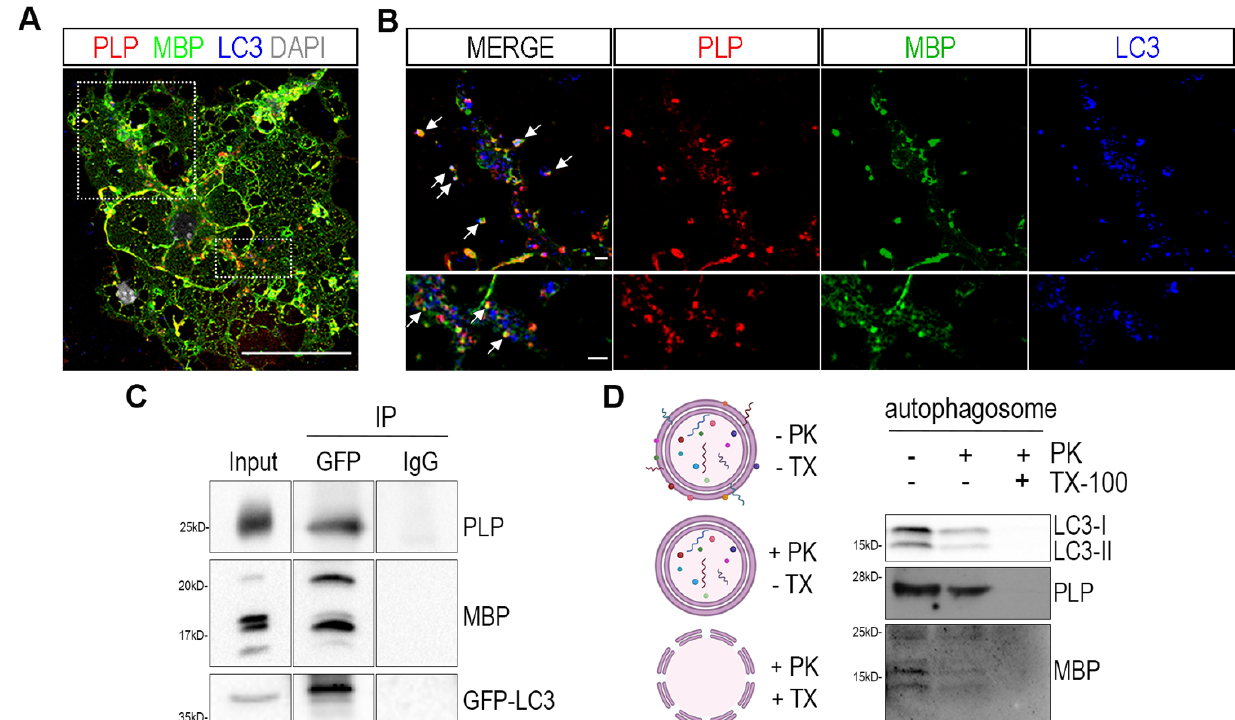
FIGURE 3: Myelin proteins PLP and MBP are detected in the autophagosomes. (A) Representative confocal image of a DIV2 primary OL, immunolabeled for MBP (green), PLP (red), LC3 (blue) and DAPI (grey). Rectangular boxes indicate areas magnified to the right. Scale bar: 30 μm. (B) Magnification images are of a single z-stack (0,5μm thick) and white arrows indicate the colocalized puncta in myelin membrane (top) and cytoplasmic processes (bottom). Scale bars: 2 μm. (C) Immunoprecipitation with antibodies against GFP in forebrain lysates from